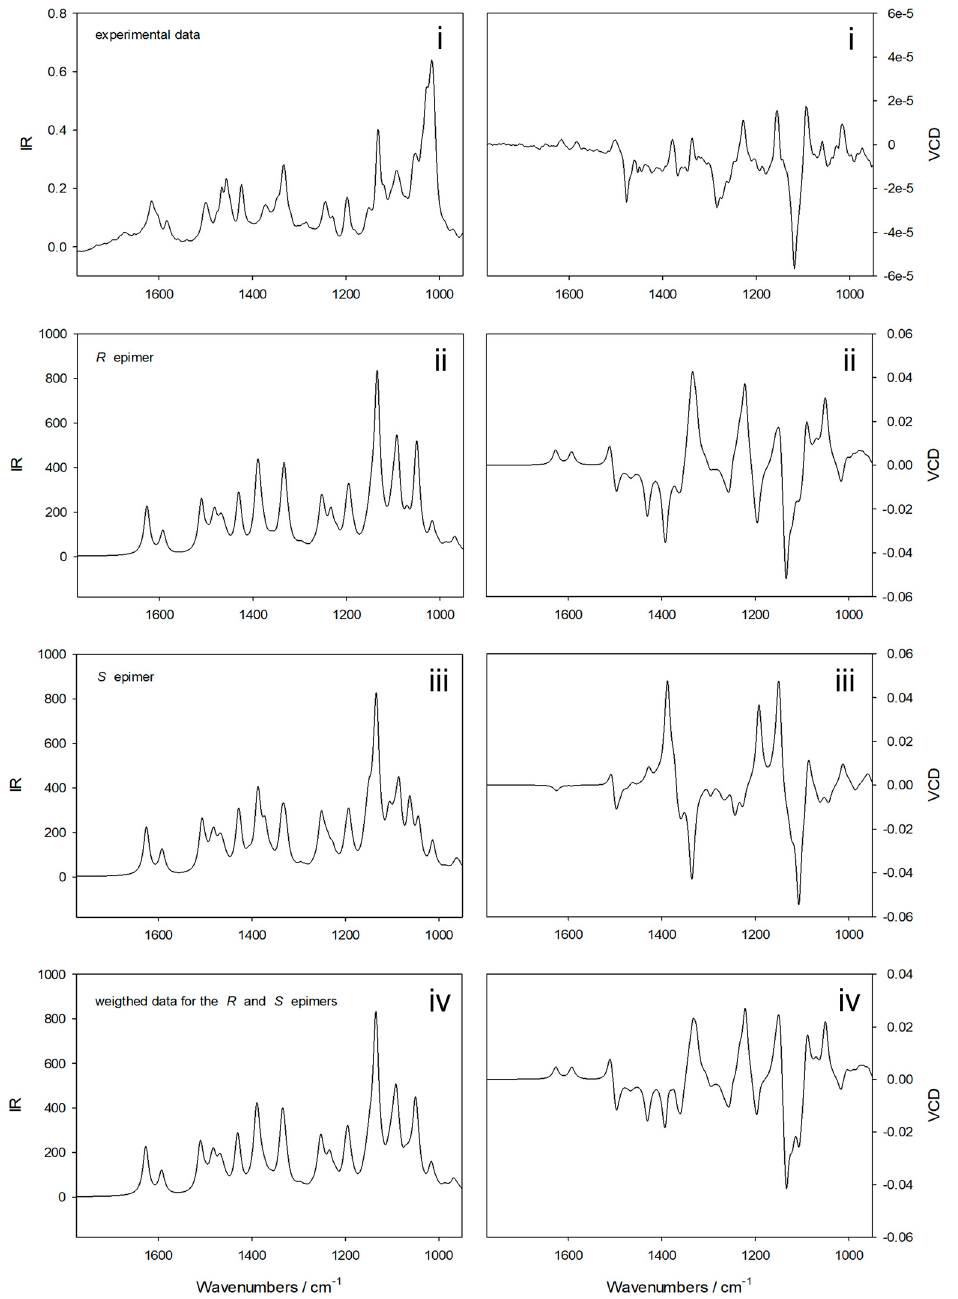
Figure 8. Experimental IR and VCD spectra confirming the absolute configurations of compounds 1 and 2 . From top to bottom, the data shown refer to ( i ) the experimental data obtained for the sample, ( ii ) the Boltzmann weighted IR and VCD spectra for the (3 R ,4 R ,5 R ,6 R ,10b R ) epimer, ( iii ) the Boltzmann weighted IR and VCD spectra for the (3 R ,4 R ,5 R ,6 S ,10b R ) epimer, and ( iv ) the weighted IR and VCD spectra obtained using the 3.15:1.00 ratio for major and minor epimers as derived from the NMR data.